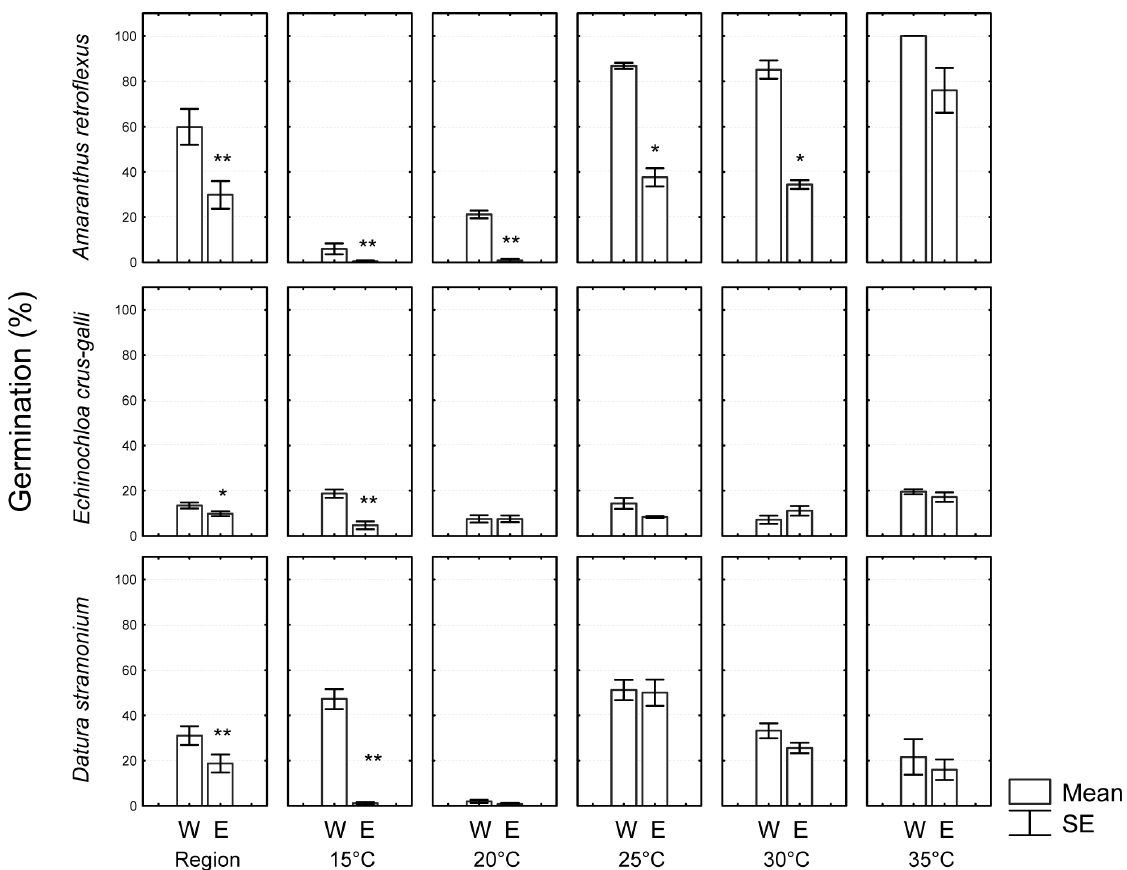
Figure 2. Temperature-dependent seed germination rates of A. retroflexus , E. crus-galli , and D. stramonium reached at the end of a six- week period in a climate chamber experiment. Seeds originated from two sub-regions (W = western part, E = eastern part) of Kosovo. Values show mean and standard error for five replicates (50 seeds per replicate). The first column of graphs presents the mean over all tested temperatures. Significance levels for sub-region obtained from GLMs (Table 3) and for temperature levels from Tukey HSD post hoc tests (**p < 0.001, *p<0.05).